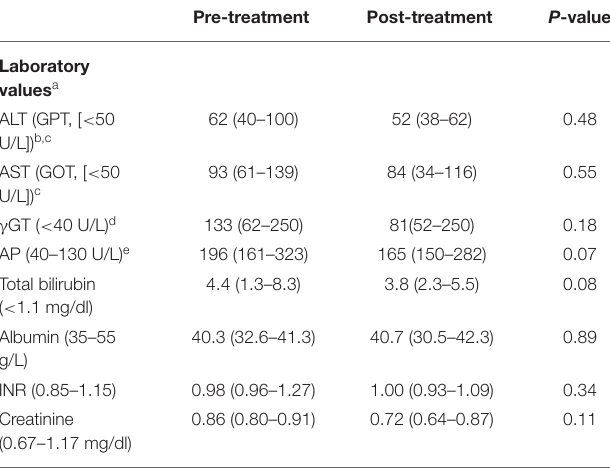
TABLE 1 | Clinical and laboratory characteristics of pruritic and non-pruritic patients as well as healthy controls. Pruritus No pruritus Controls